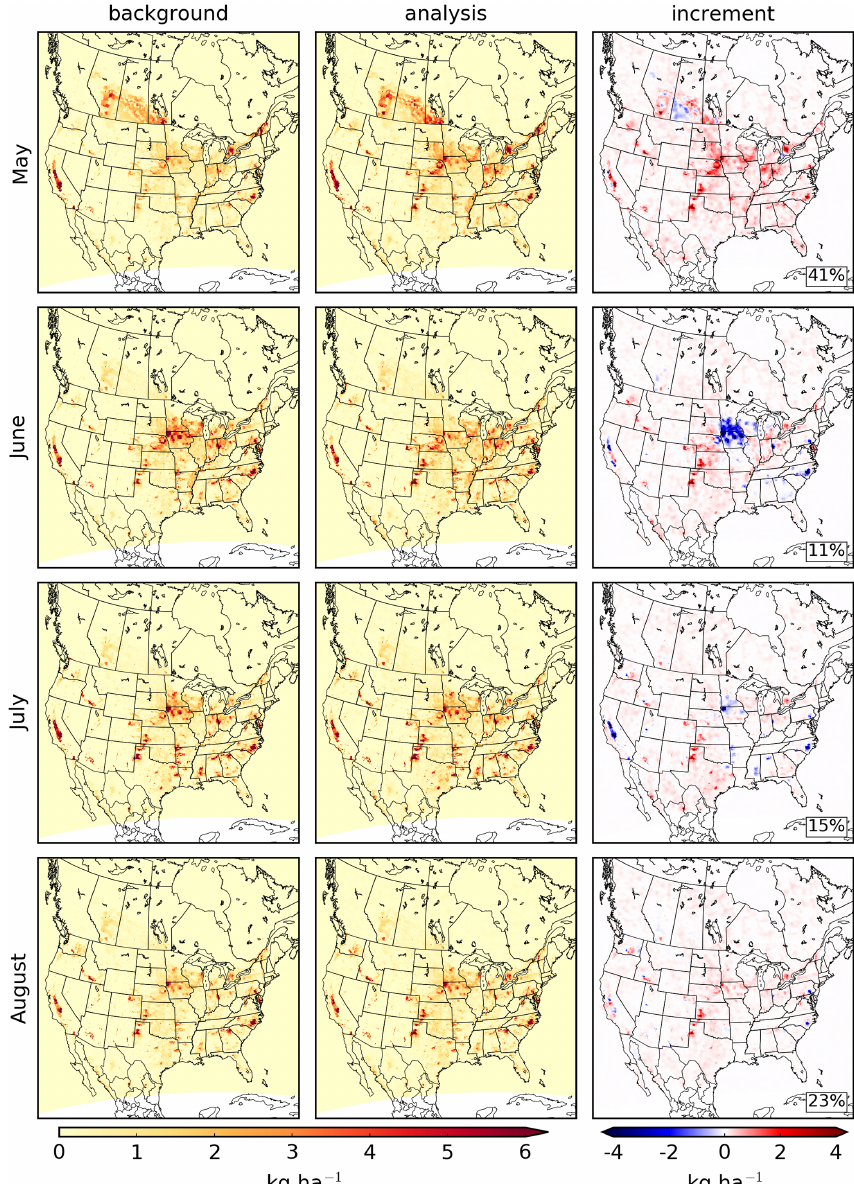
Figure 3. Monthly ammonia emissions for May to August 2016 on the GEM-MACH model grid. The left column shows the original set of emissions (the background) that are described in Sect. 2.3. The middle column shows the emissions produced by the inversions (the analysis), while the right column shows the difference between the two (the increment). For plots on the right, the percentages in the lower right corner show the change over the whole